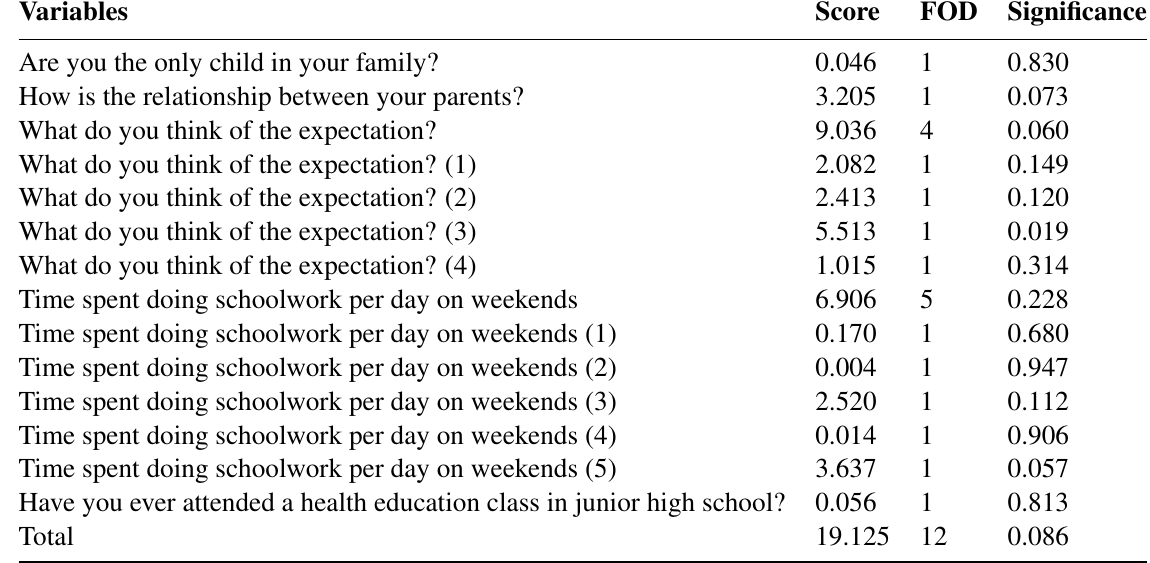
Table 6 Variables omitted from the binary logistic regression